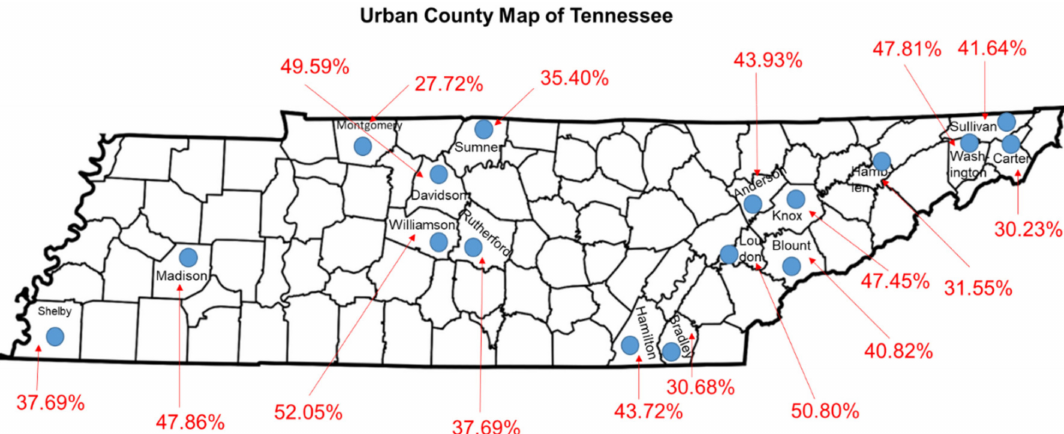
Figure 4. Vaccination rates in the 17 urban Tennessee counties. Urban counties are labelled in black and designated as blue ovals. Vaccinations are given as percentages in red text. Vaccination rates were obtained from the Tennessee Department of Health. https://www.tn.gov/health/cedep/ncov/data.html (accessed on 11 July